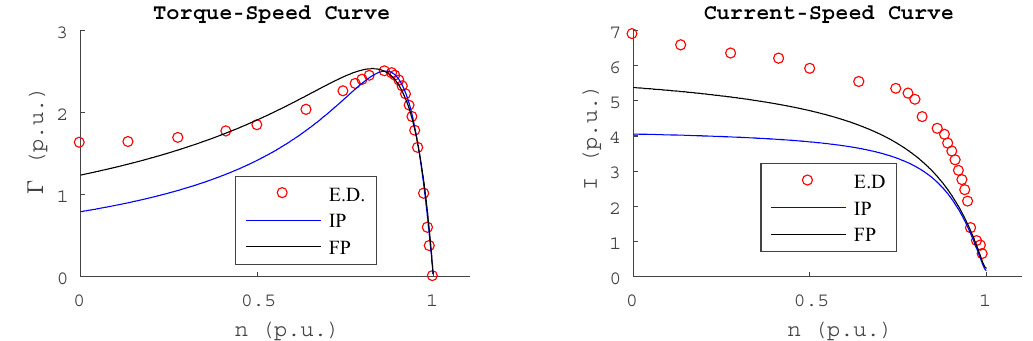
Figure 12. Torque–speed and current–speed with the final parameter (FP) vs. initial parameters (IPs).